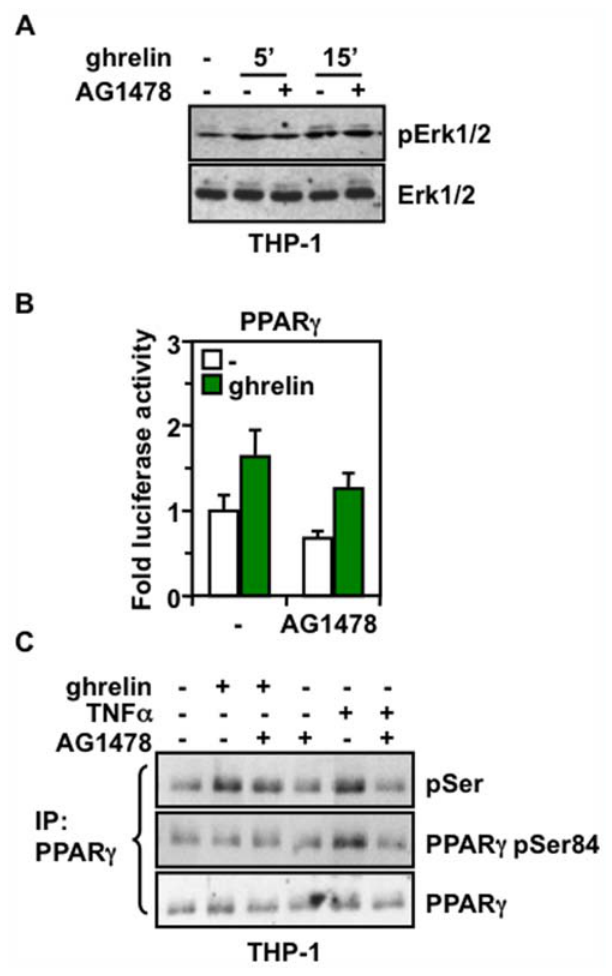
Figure 3. The effects of ghrelin on PPAR c are independent of the EGF receptor. ( A ) Phosphorylation of Erk1/2 in differentiated THP- 1 cells serum-deprived for 16 h and treated with 5 m M of the EGFR inhibitor AG1478 for 30 min before incubation with 10 nM ghrelin for 5 and 15 min. The lysates were analyzed by immunoblot using a phospho-Erk1/2 antibody and normalized with an anti-Erk1/2 antibody. ( B ) Effect of EGFR inhibition on PPAR c activity using 293 cells transfected with UAStkLuc reporter along with Gal4-PPAR c and GHS- R1a plasmids, and then treated with 10 nM ghrelin with or without 5 m M EGFR inhibitor AG1478 for 20 h before harvested for